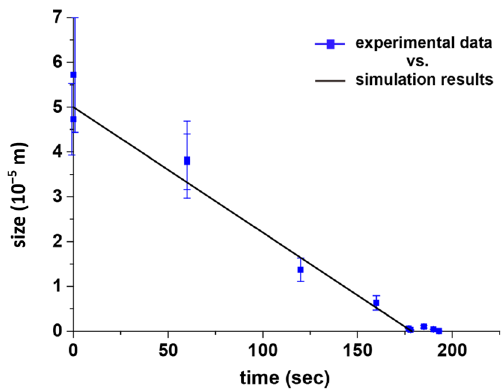
Figure 6. Controlled particle size based on the programmed time-parameter during the two-stage CVSD fabrication process. The simulation and experimental results were mutually consistent. The data points were expressed as the mean value and the standard deviation based on three independent experiments.